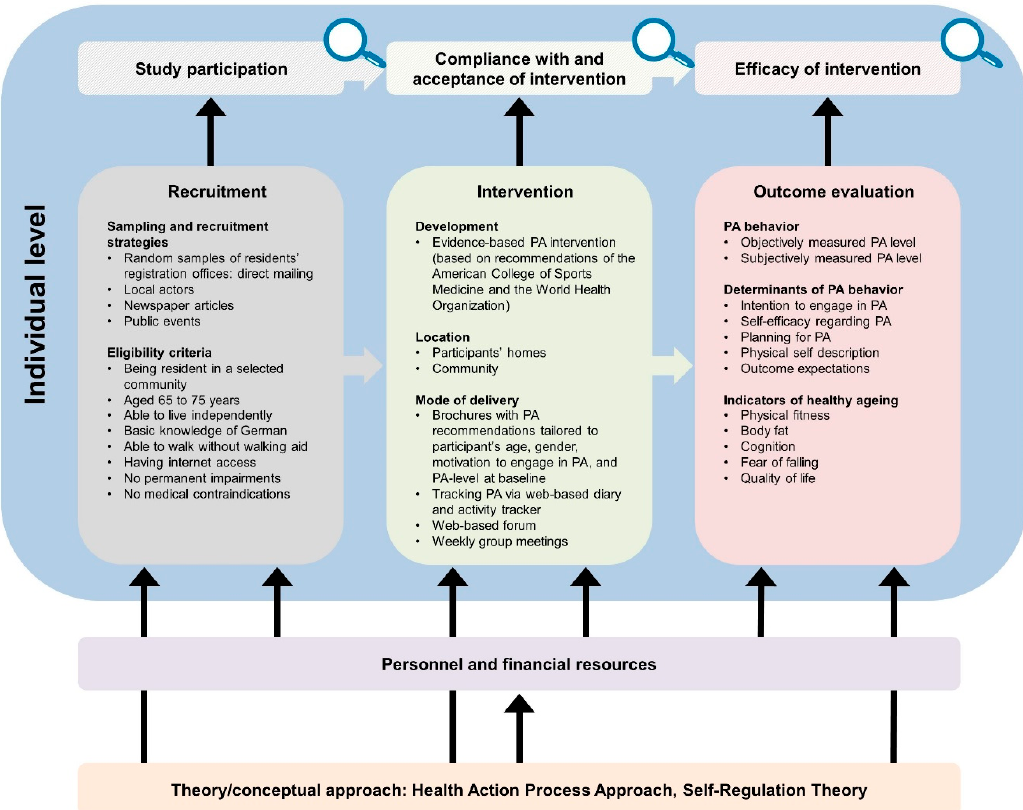
Figure 2. Specific equity-focused logic model for the individual-level web-based tailored intervention aimed at promoting physical activity (PA) and fitness in older adults implemented in PROMOTE.